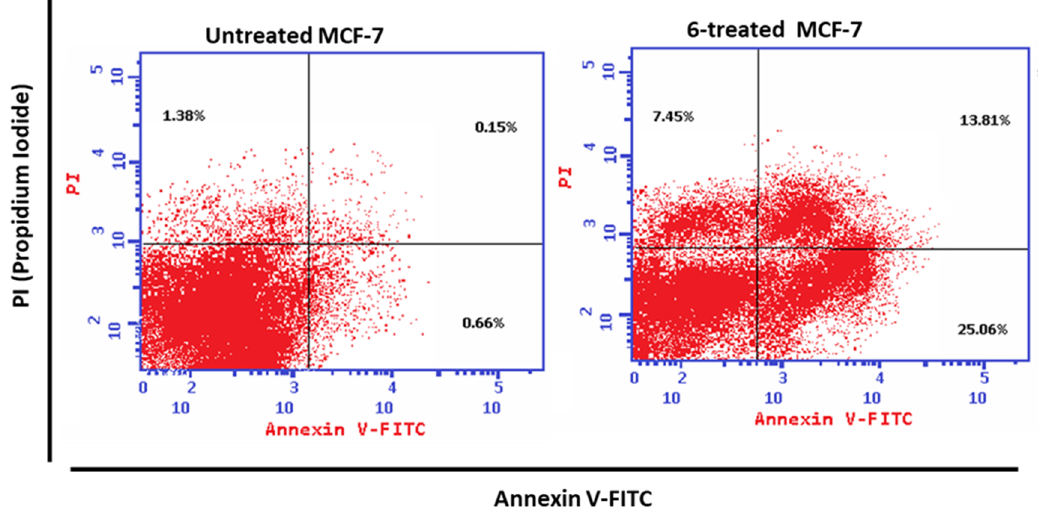
Figure 4. Cryptographs of Annexin V/Propidium Iodide staining of ( left ) untreated and ( right ) 6-treated MCF-7 cells with IC 50 values, 48 h. Q1-UL (necrosis, AV–/PI+), Q2-UR (late apoptotic cells, AV+/PI+), Q3-LL (normal cells, AV–/PI–), and Q4-LR (early apoptotic cells, AV+/PI–).